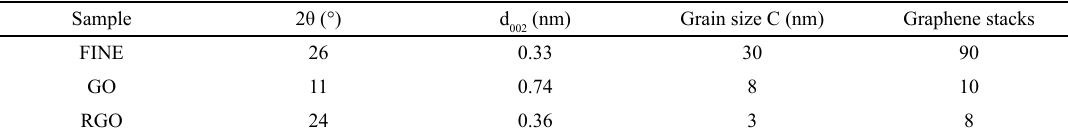
Table 1. Data obtained from the XRD patterns for FINE, GO and RGO. Sample